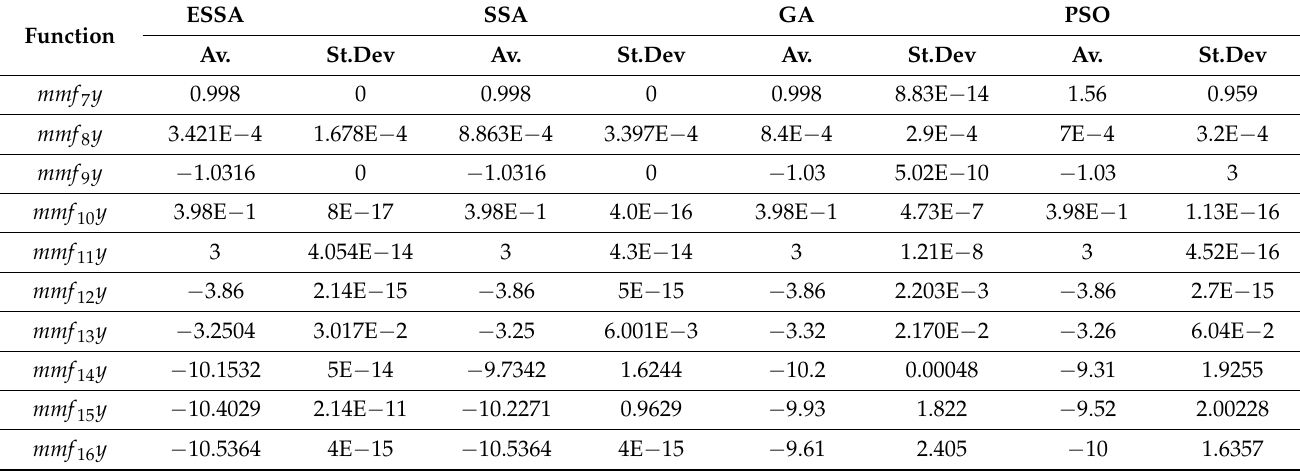
Table 4. Statistical results for fixed dimensional